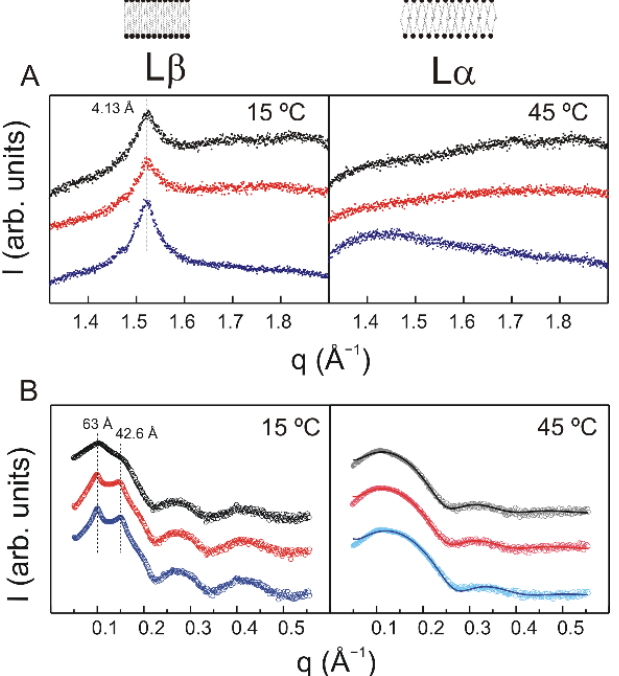
Figure 3. ( A ) Intensity (arbitrary units) vs. scattering vector (q) for WAXD profiles of pure DMPS (top) and DMPS containing TMBC at 0.07 (middle) and 0.20 molar fraction (bottom) at different temperatures. ( B ) Intensity (log scale in arbitrary units) vs. scattering vector (q) for SAXD profiles of pure DMPS (top) and DMPS containing TMBC at 0.07 (middle) and 0.20 molar fraction (bottom) at different temperatures. Solid lines at 45 ◦ C represent the best fit to the experimental patterns using the GAP